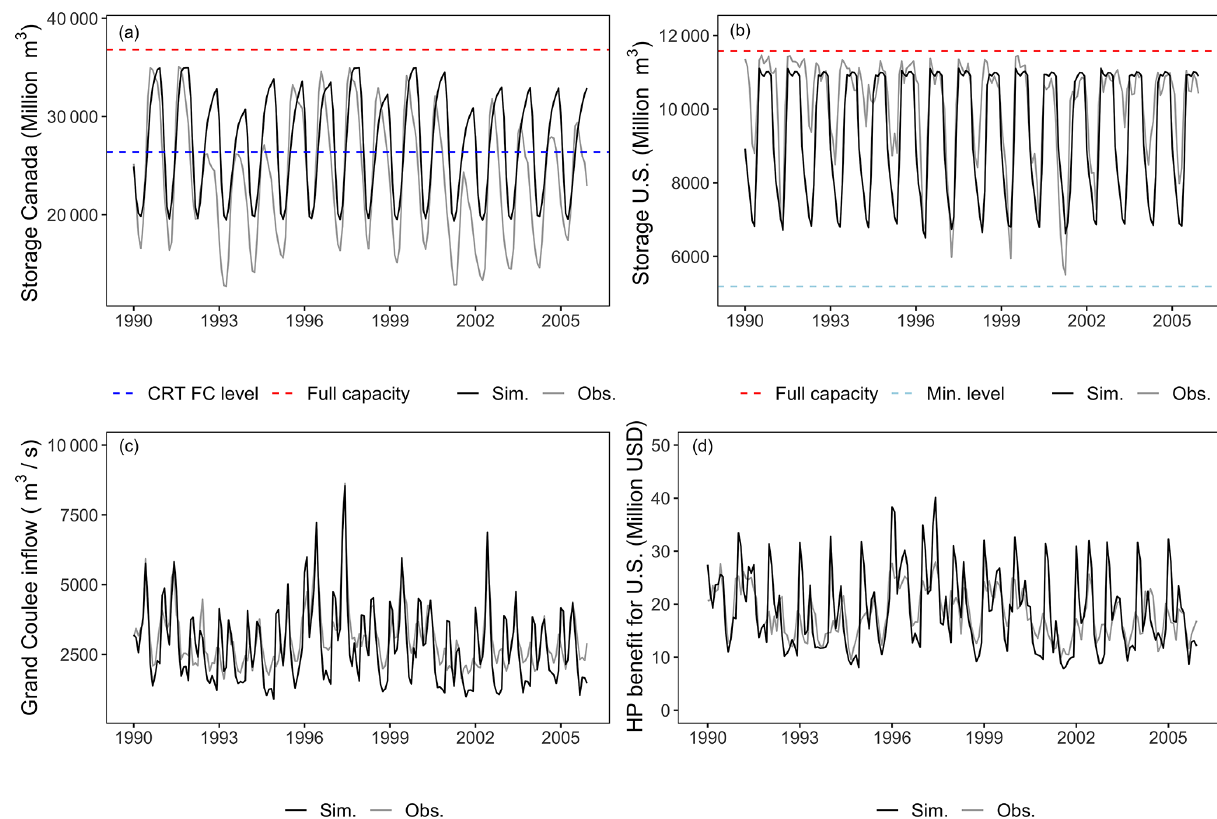
Figure 5. Calibration result from 1990–2005 showing (a) Canadian storage, (b) US storage, (c) Grand Coulee inflow, and (d) hydropower benefit for the United States. Note that sim. – simulated, obs. – observed, full capacity – maximum capacity, CRT FC level – CRT flood protection target level, and min. level – minimum capacity for the US dams. Table 4. Calibration (1990–2005) and validation (2006–2017)